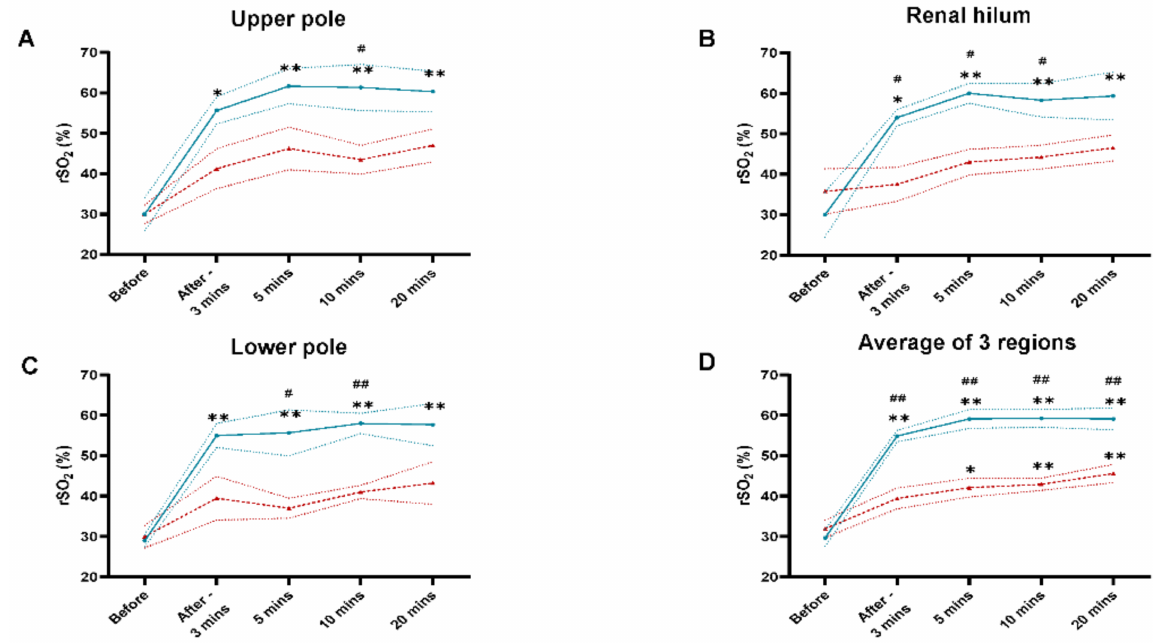
Figure 1. Tissue oxygen saturation (rSO 2 ) level curves of the kidney allograft in living ( n = 3, solid turquoise line and closed circles) and deceased donor renal transplants ( n = 4, dash red line and closed triangles) before and after 20 min (mins) of reperfusion. Tissue oxygen saturation levels of the kidney allograft in living and deceased donor renal transplants were measured at three regions (upper pole, renal hilum, and lower pole) using a handheld tissue oximetry sensor device before and after reperfusion at 3, 5, 10 and 20 min. ( A ) Tissue oxygen saturation level curves measured at the upper pole of the kidney allograft. ( B ) Tissue oxygen saturation level curves measured at the renal hilum of the kidney allograft. ( C ) Tissue oxygen saturation level curves measured at the lower pole of the kidney allograft. ( D ) Average tissue oxygen saturation level curves measured at three regions of the kidney allograft. * p < 0.05 vs. before reperfusion. ** p < 0.01 vs. before reperfusion. # p < 0.05 vs. deceased donor kidney allografts. ## p < 0.01 vs. deceased donor kidney allografts. Data are expressed as mean ±